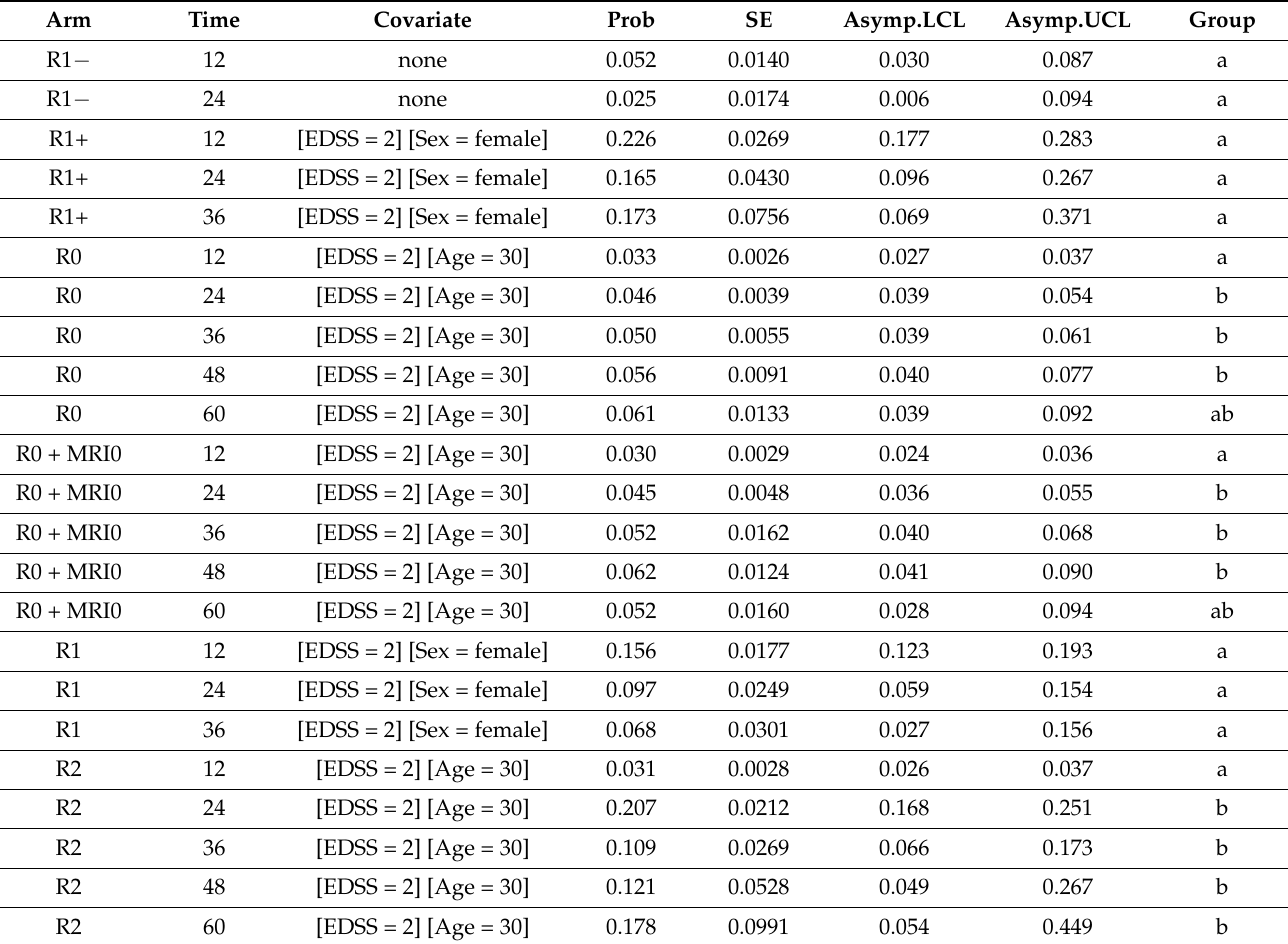
Table 2. Estimated adjusted means from the logistic